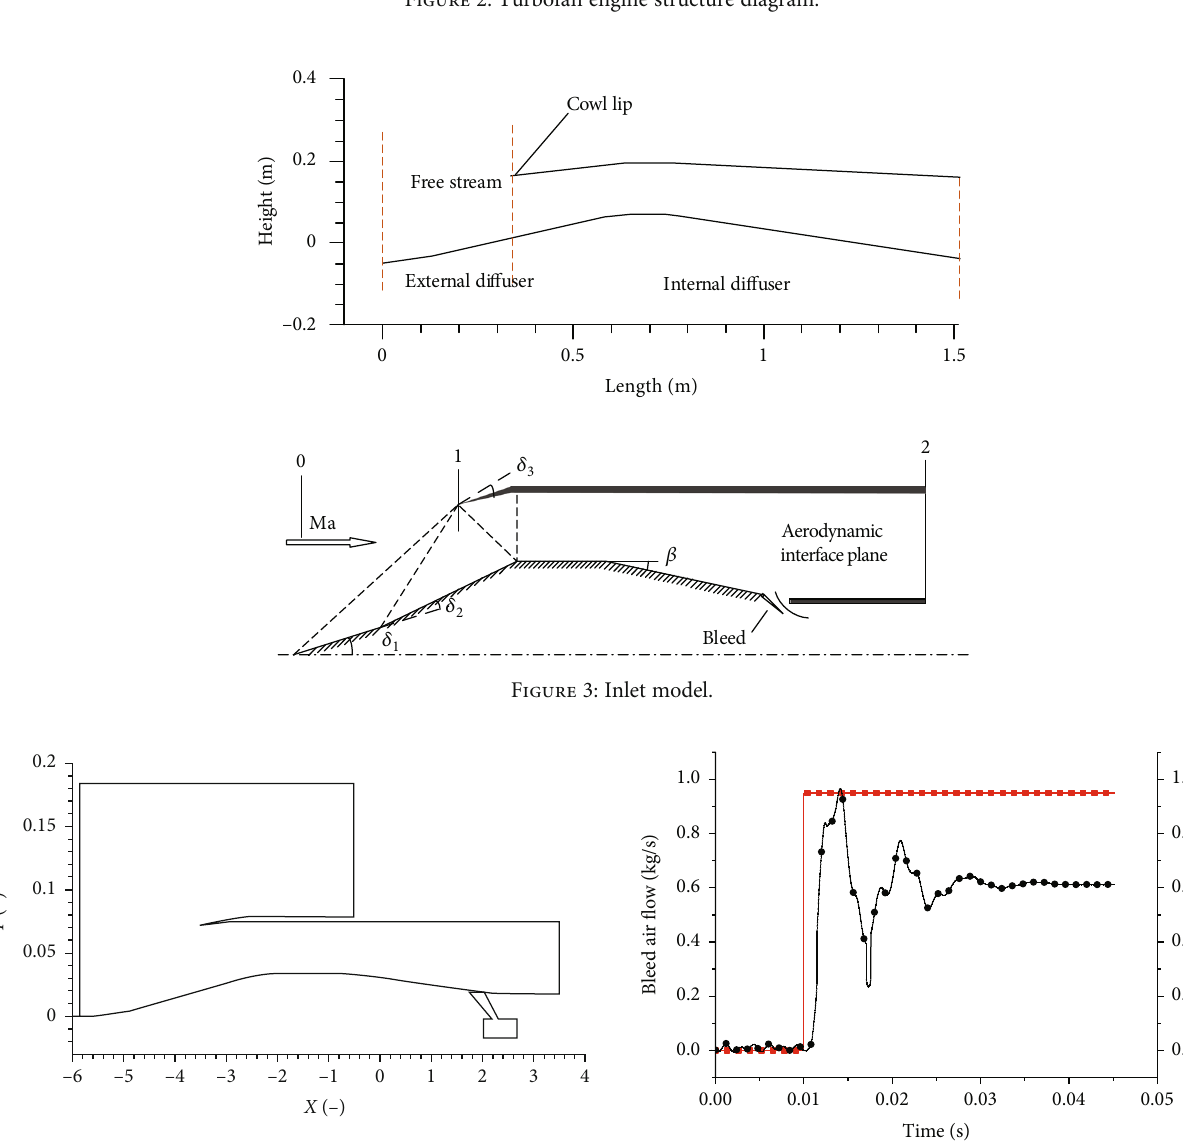
Figure 4: Computational model.